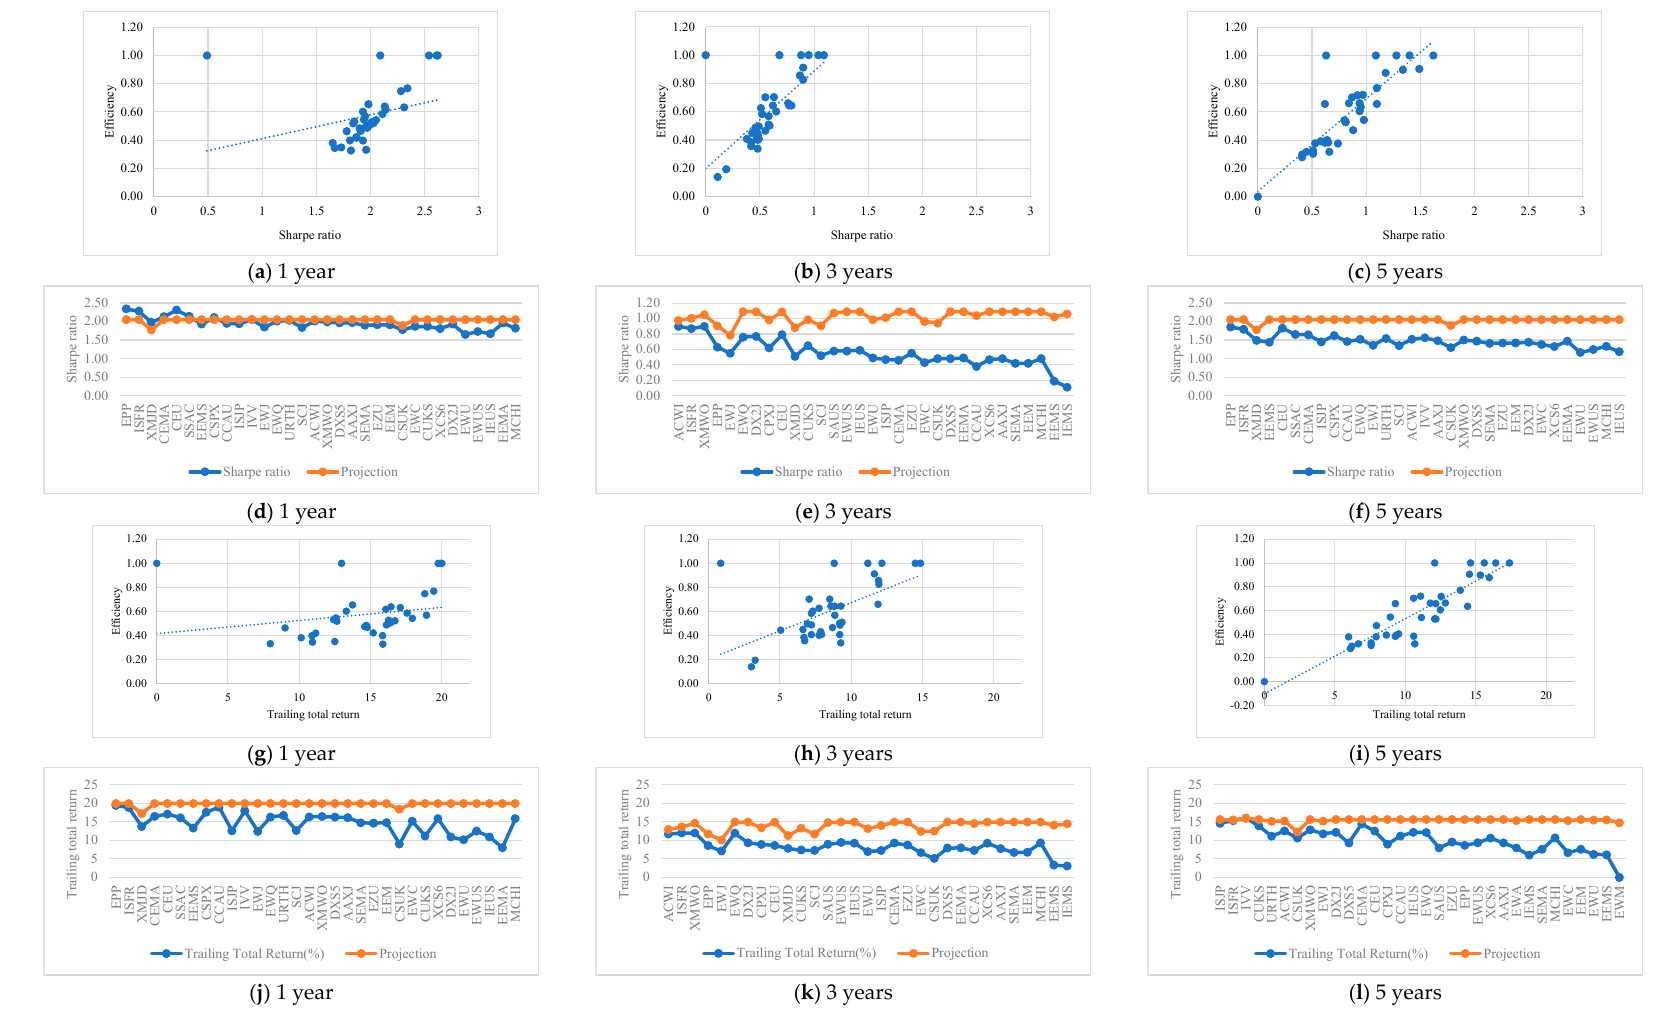
Figure 6. Efficiency scores vs. outputs and projections (ETFs are ordered in decreasing order of efficiency) for the different time horizons–M3.